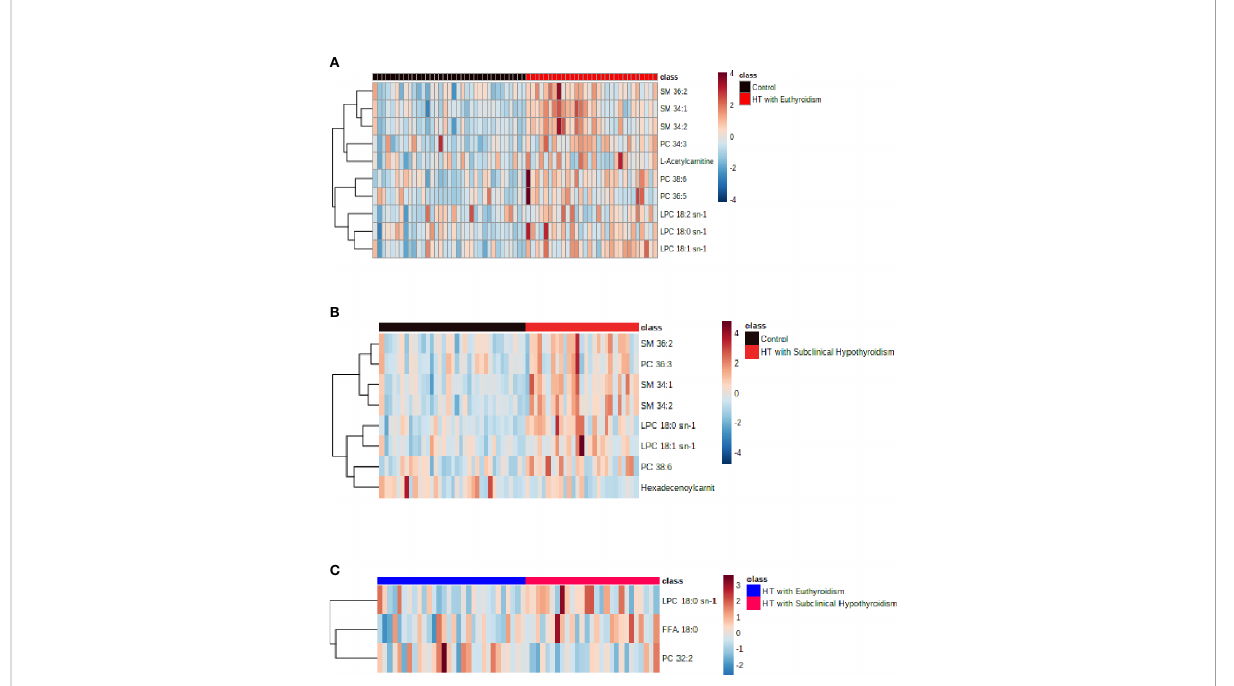
FIGURE 3 (A) The heatmap of metabolites from comparison between the control and HT with euthyroidism group. (B) The heatmap of metabolites from comparison between the control and HT with subclinical hypothyroidism group. (C) The heatmap of metabolites from comparison between the HT with euthyroidism and HT with subclinical hypothyroidism group.